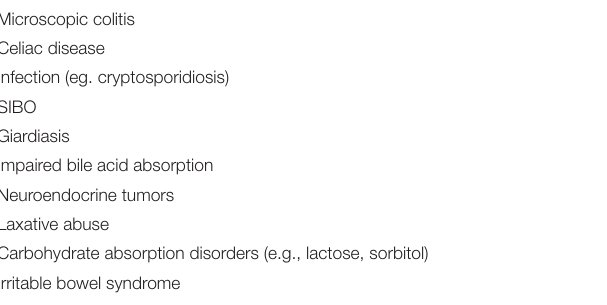
TABLE 3 | Differential diagnosis of chronic diarrhea, when the endoscopic picture is normal. Microscopic